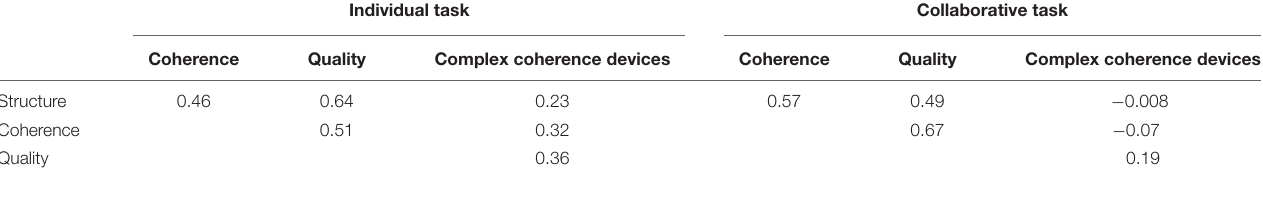
TABLE 4 | Correlations among reader-based and text-based measures at